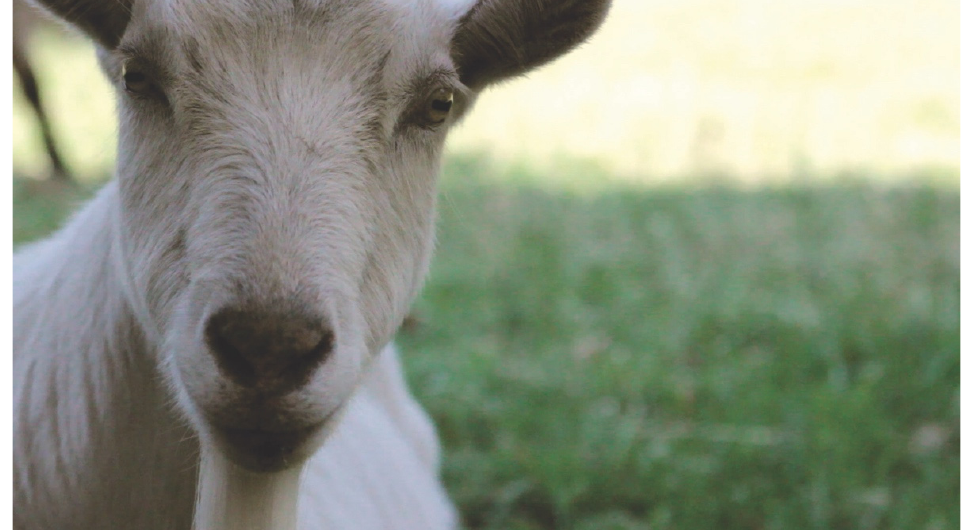
Figure 5. How Long Will You Sleep (2019). Digital film still.